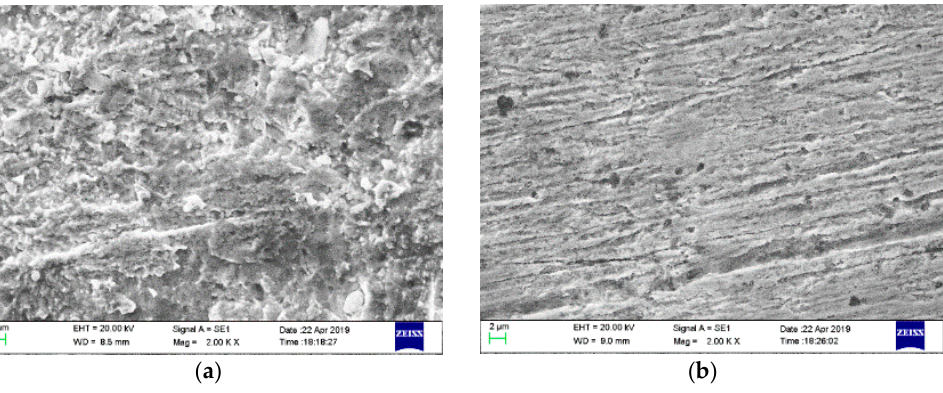
Figure 8. SEM images of a ( a ) copper surface in a 3.5% NaCl solution, and a ( b ) copper surface coated with GG-AMPS in a 3.5% NaCl solution.